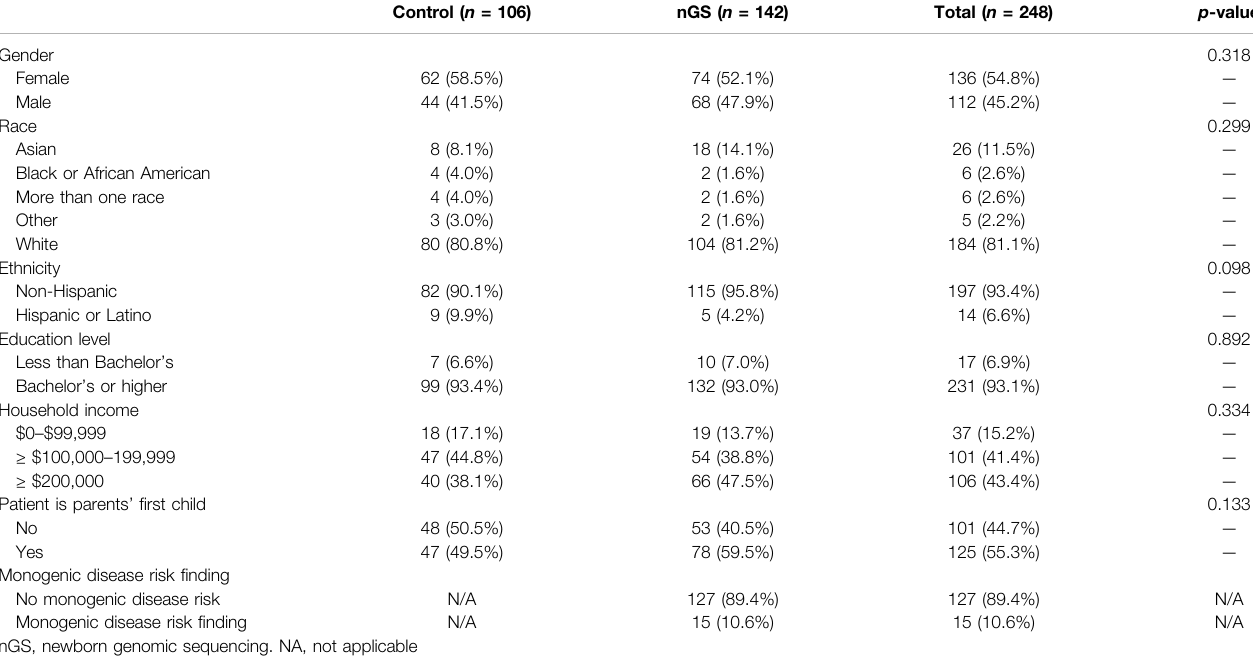
TABLE 1 | Demographic characteristics of parents who completed baseline and 3 months post-disclosure